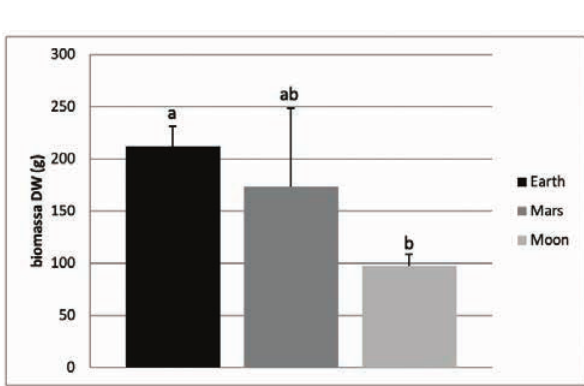
Figure 2: Total aboveground combined dry biomass production for ten different crops, garden cress, rocket, tomato, radish, rye, quinoa, spinach, chives, pea and leek on Mars and Moon soil simulant and Earth organic soil (control). Different letters indicate significant differences (n=3, p<